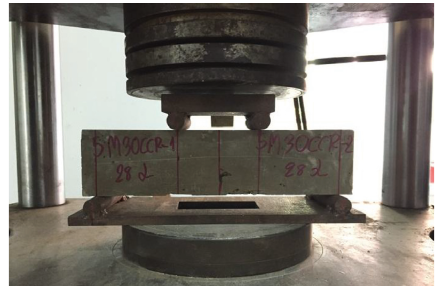
Figure 4: Test setup for flexural strength.